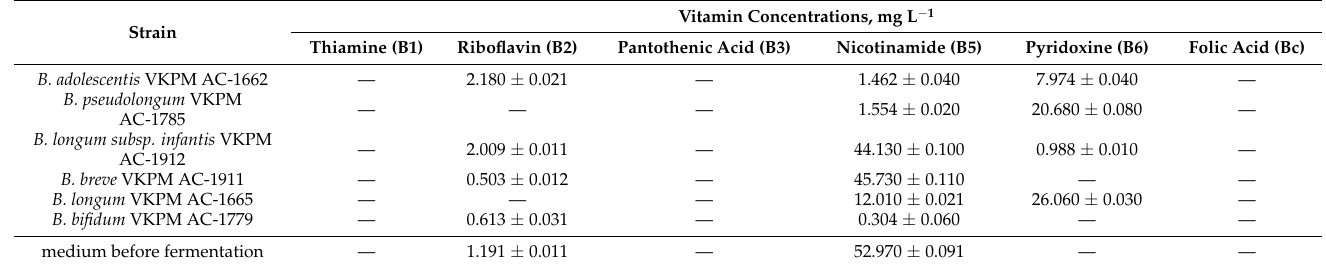
Table 12. Concentration of B vitamins in bifidobacteria fermentation broths.